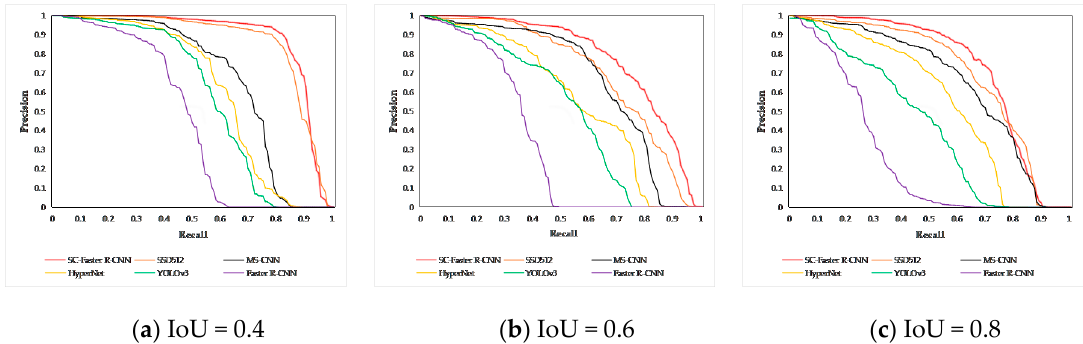
Figure 7. Detection of ( a ) small, ( b ) medium, and ( c ) large objects in test set of 07 + 12 dataset by various deep neural network algorithms .